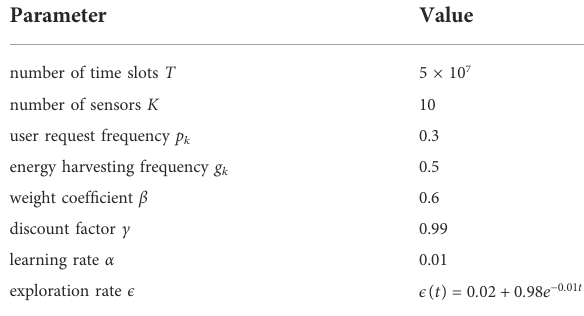
TABLE 1 Simulation parameters of the nonideal channel model.